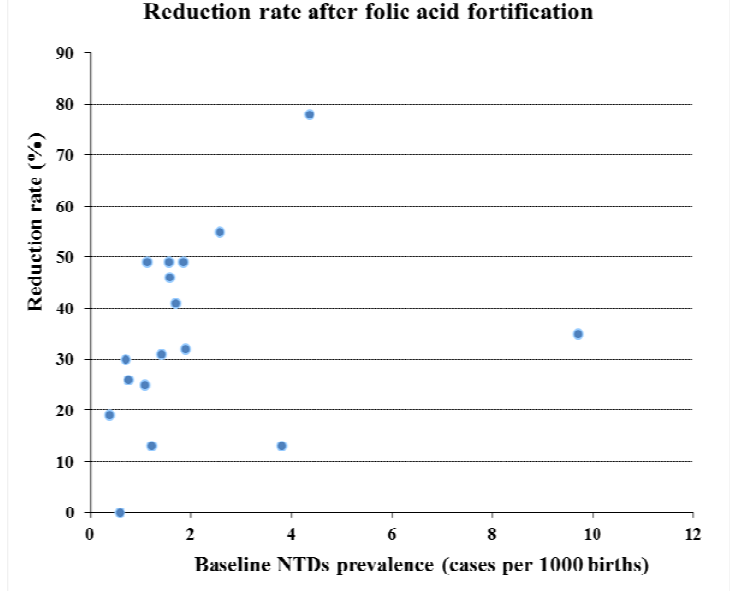
Figure 2. Reduction rate of NTDs after FA food fortification depending on baseline